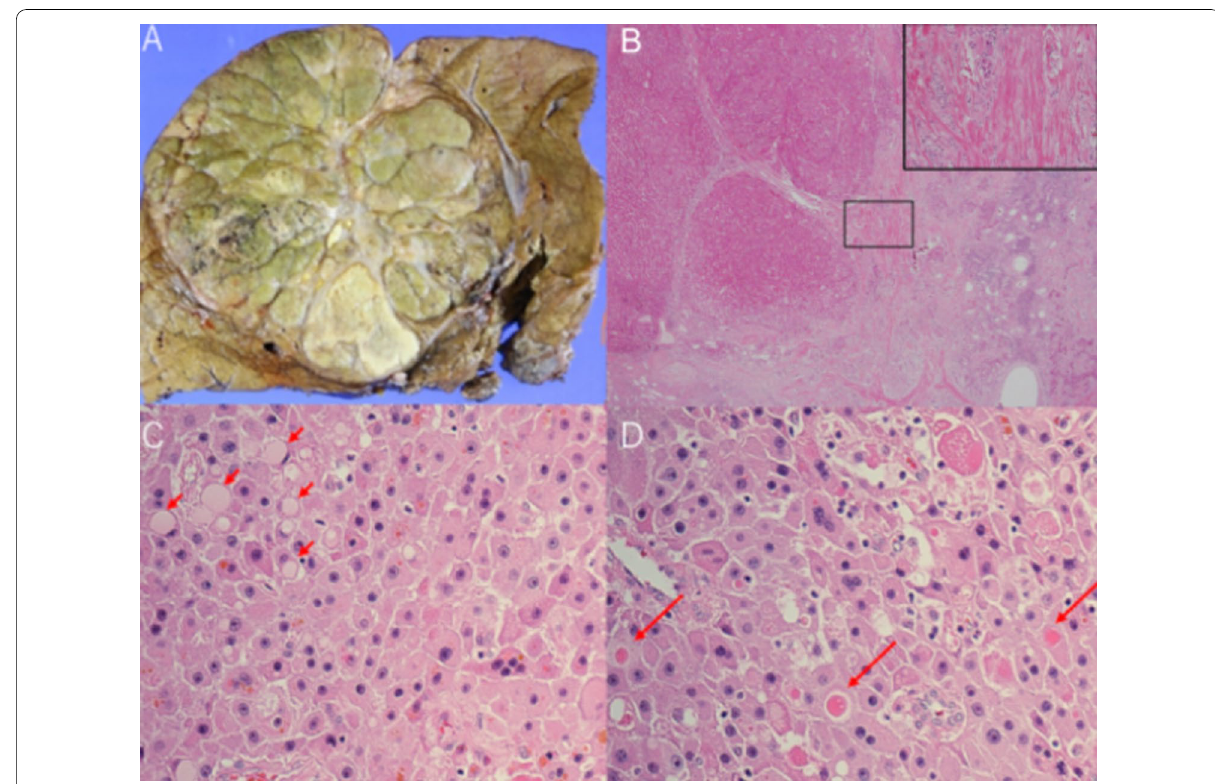
Fig. 2 Pathological view of the tumor. The tumor was a well-defined lobulated tumor with a central scar on gross examination ( A ). The central portion of the tumor showed abundant fibrous stroma in a lamellar pattern (inset) containing tumor cells. (H&E, large nuclei and often contained pale bodies (short arrows) (H&E, arrows, 400) ( D ×